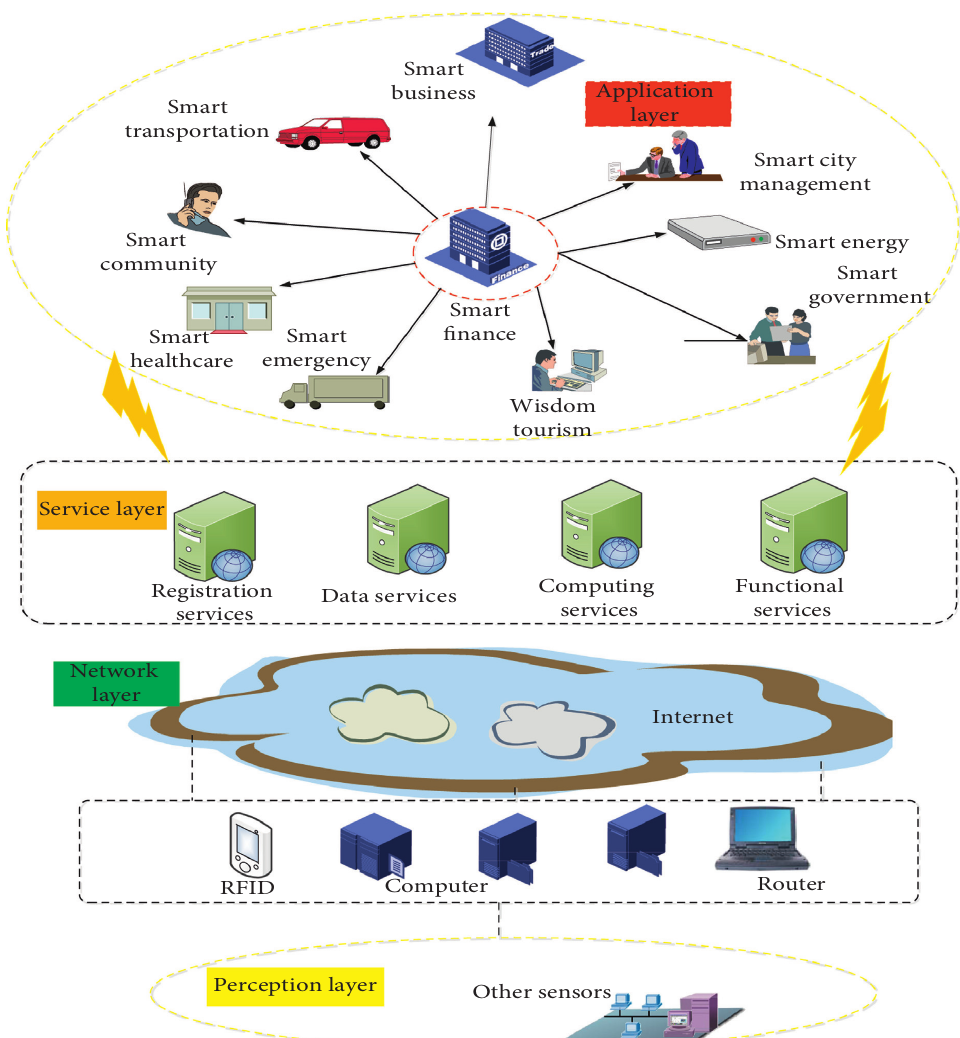
Figure 1: Basic architecture of a smart